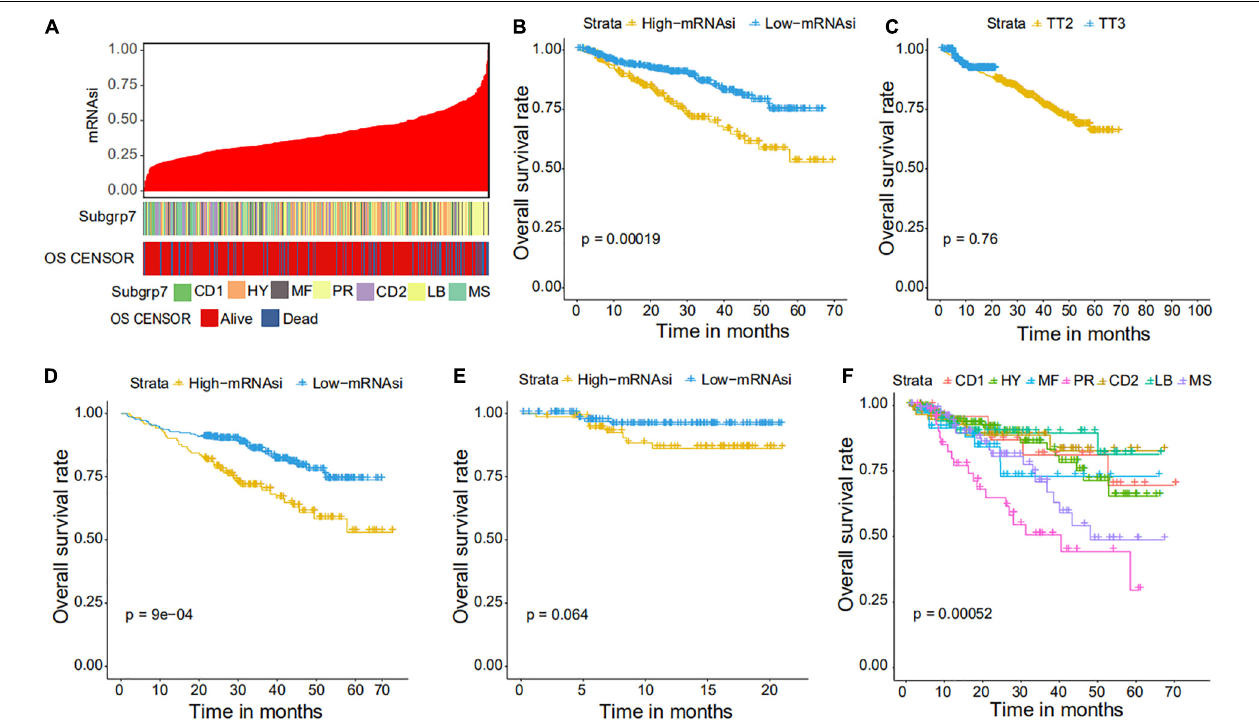
FIGURE 3 | Clinical characteristics related to the mRNAsi in the GSE4204 cohort. (A) Overview of the association between subtype and mRNAsi in MM. The columns represent samples sorted by mRNAsi from low to high (top row), while the rows represent the demographic factors associated with mRNAsi. (B) The Kaplan–Meier curve was used to determine the OS of patients in the MM group with high and low mRNAsi. (C) The Kaplan–Meier curve was used to determine the OS of patients treated with the TT2 or TT3 regimen. (D) The Kaplan–Meier curve was used to determine the OS of high and low mRNAsi patients treated with the TT2 regimen. (E) The Kaplan–Meier curve was used to determine the OS of high and low mRNAsi patients treated with the TT3 regimen. (F) The Kaplan–Meier curve was used to determine the OS of patients of different MM